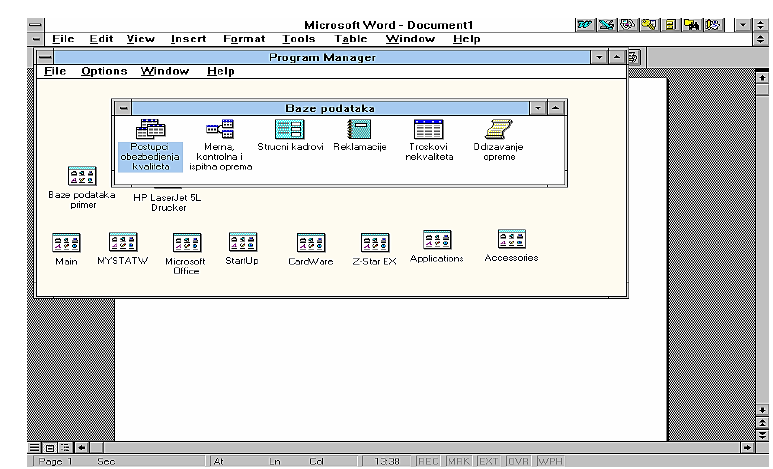
Figure 6 – ”Program Manager” window with the window